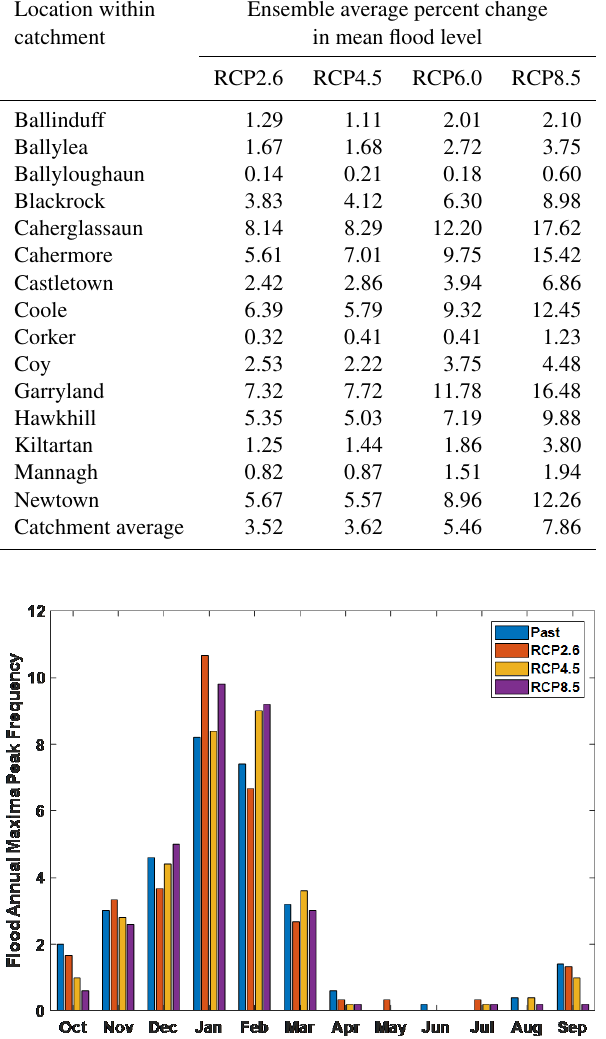
Figure 6. Bar chart illustrating the seasonal shift in frequencies of peak annual flood levels at Coole turlough over the hydrological year for all future RCM scenarios (with RCP6.0 omitted). Note that Coole turlough is one of the key turloughs in the catchment and is therefore representative. The y axis shows the number of times (or frequency) when the annual maximum peak flood level occurred during each month of the year for the RCP